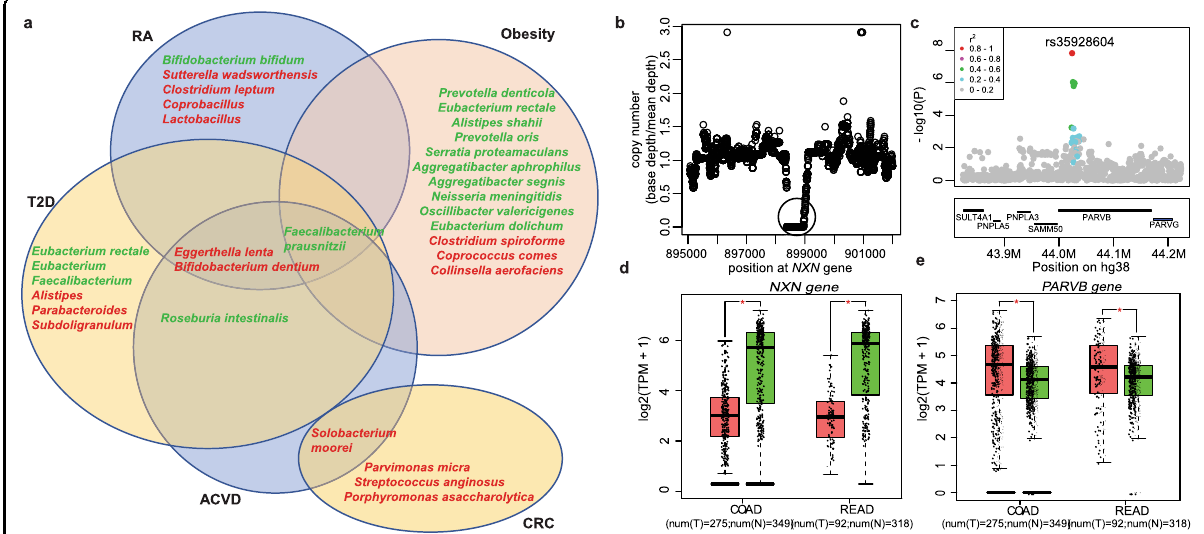
Fig. 4 M-GWAS helps understand biomarkers from MWAS. a Venn diagram showing the bacteria that identi fi ed associated with genetic variants and were reported in multiple MWAS studies, including type 2 diabetes (T2D), rheumatoid arthritis (RA), atherosclerotic cardiovascular disease (ACVD), colorectal cancer (CRC), and obesity. Bacteria in overlapping areas indicates it was reported in two or more MWAS studies. The bacteria marked in red represents enrichment in cases, and green represents enrichment in controls. b A copy loss of 642 bp (marked by green circle) in NXN gene was detected in Chinese individuals. c Box plots of the NXN gene expression in COAD and READ cases compared with normal tissue samples using GEPIA tool. COAD colon adenocarcinoma, READ rectum adenocarcinoma. d Region plot of the most signi fi cant loci for PARVB gene. Each point represents a SNP or INDEL and is colored with the r 2 value as calculated in this cohort. The lead SNP rs35928604 ( P = 1.55 × 10 − 8 ) is highlighted with red. e As in c , box plots of the PARVB gene expression in COAD and READ cases compared with normal tissue